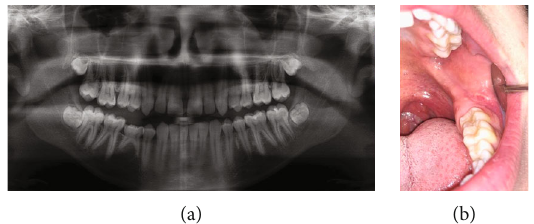
Figure 3: (a) Panoramic radiograph of case #2 prior to third molar extraction showing partially developed and bony impacted #1, 16, 17, and 32. No signs of pathology noted around the impacted #17. (b) Clinical photo post extraction with noted scar tissue at #17 extraction site but otherwise no abnormalities or